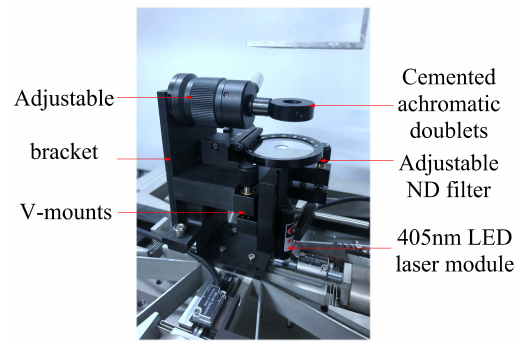
Figure 3. A cost-effective and compact optical system.